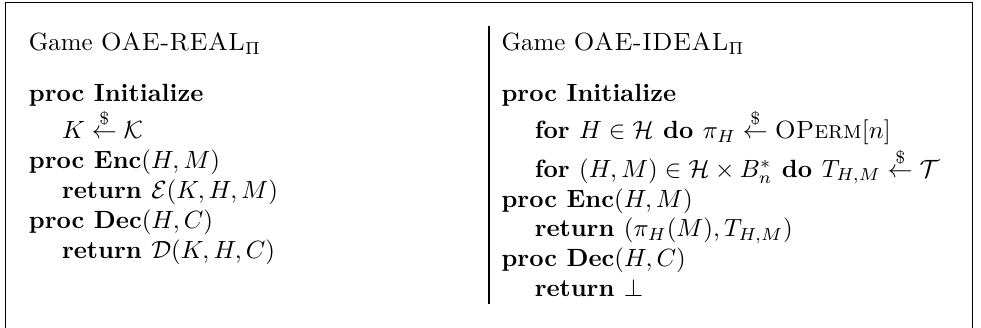
Figure 2: Games OAE-REAL Π (left) and OAE-IDEAL Π (right) used to define OAE . by Adv Prop ( t, q, b, µ ) the maximum of Adv Prop Π